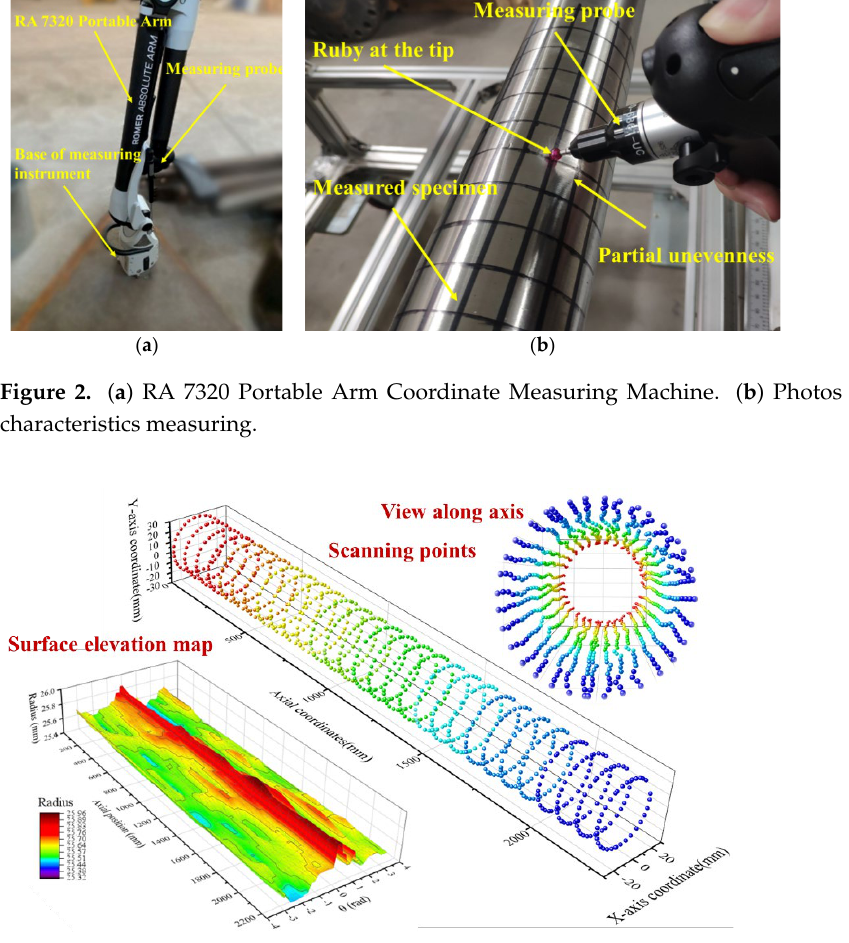
Figure 3. Schematic scanning points.